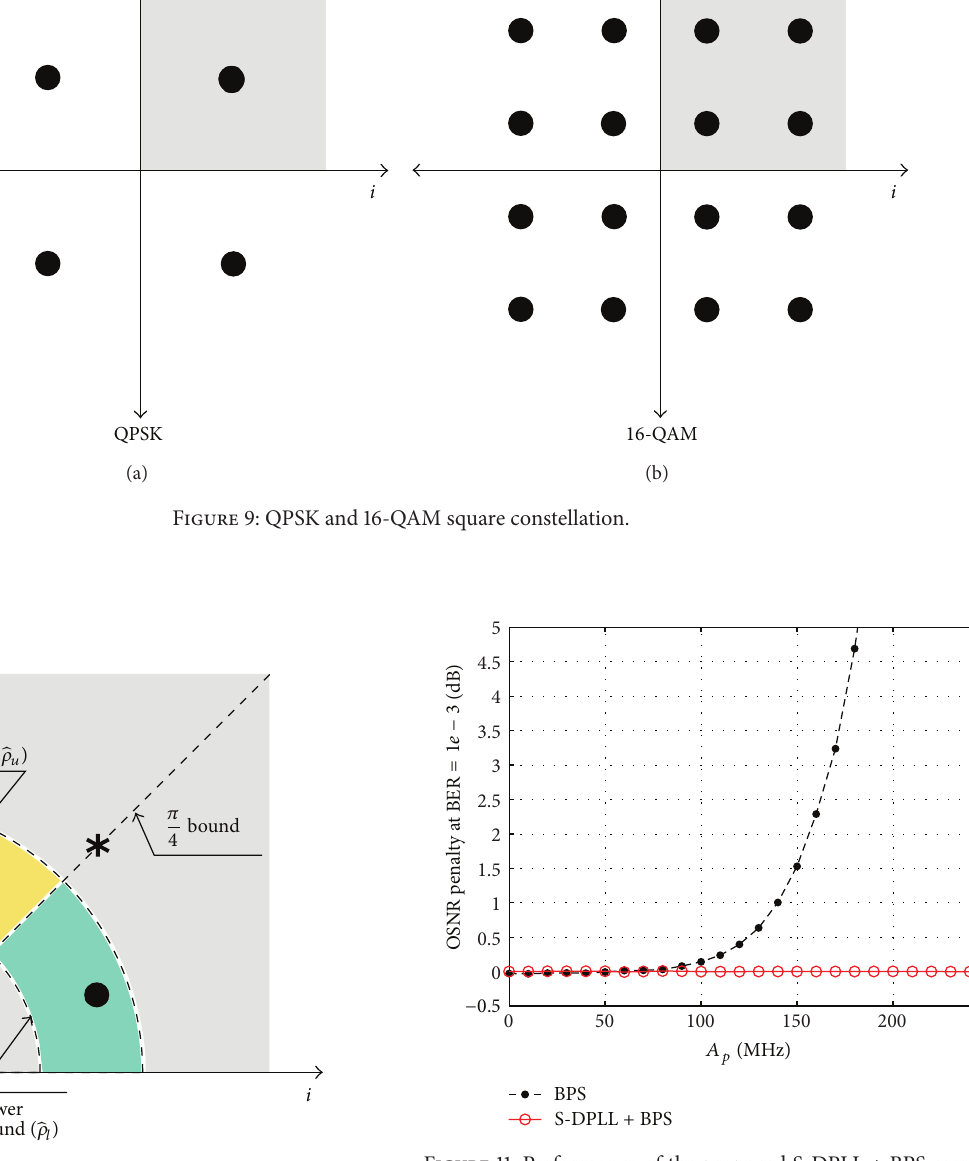
Figure 10: 16-QAM square constellation after modulus 𝜋/2 opera- tion.